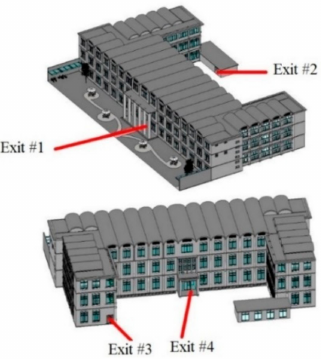
Figure 21. Exits of the building.